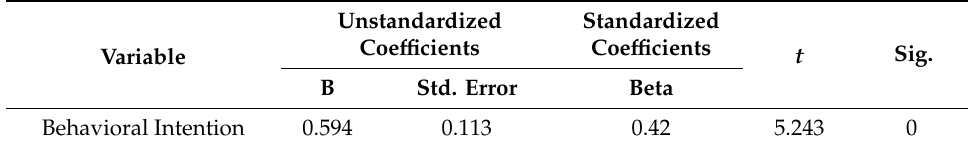
Table A5. Analysis result of usefulness, attitude, and behavioral intention (dependent variable: actual